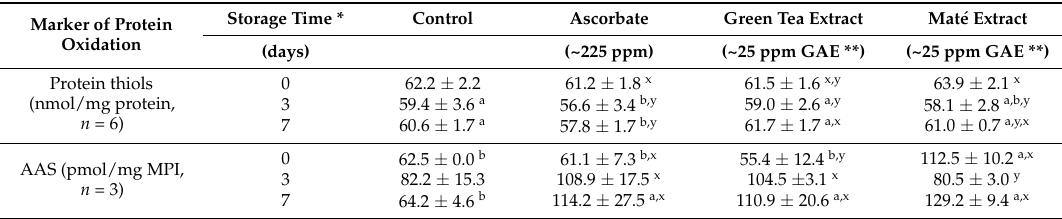
Table 3. Protein thiols and α -amino-adipic semialdehyde (AAS) in myofibrillar protein isolate (MPI) from brine-injected